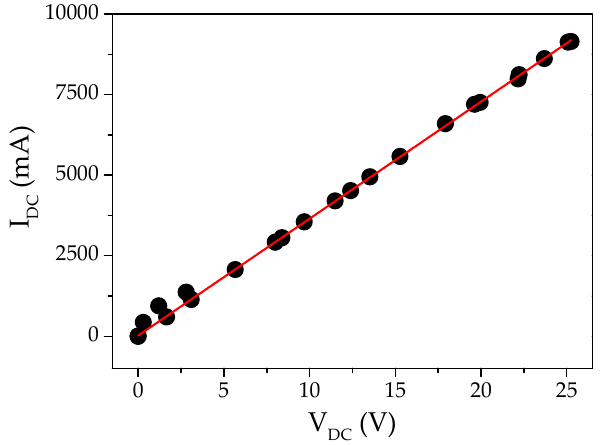
Figure 8. I–V curve of control winding. The resistance is calculated using the I–V curve.